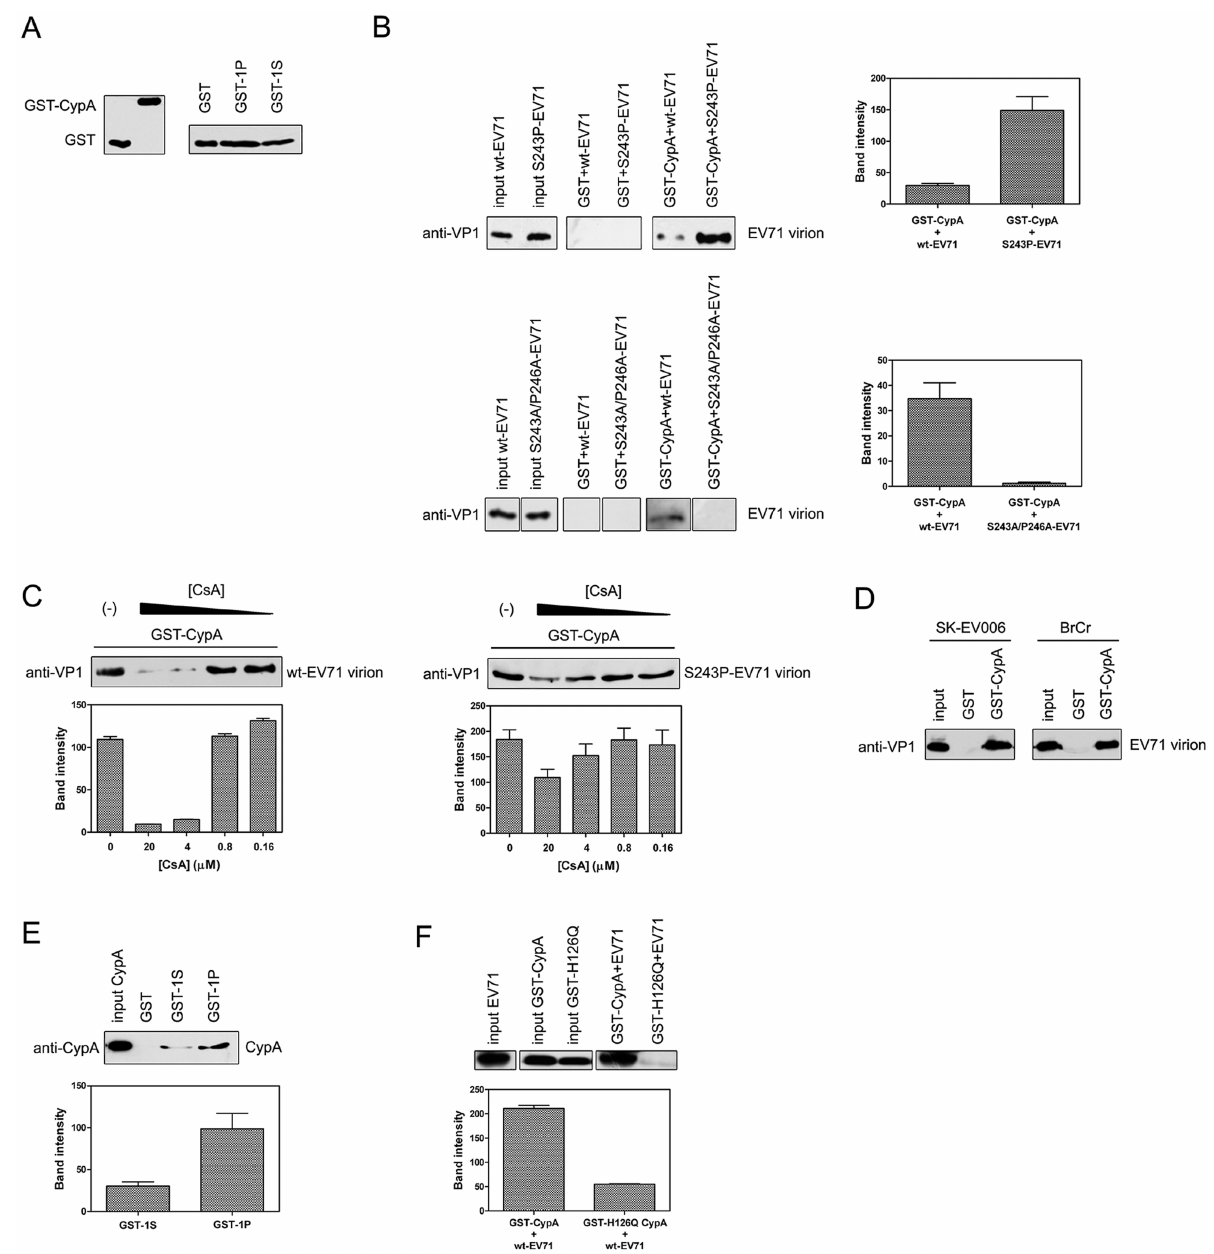
Figure 3. CypA interacted with the EV71 virion and the VP1 H-I loop. (A) Inputs that were used in the GST-pulldown assays. (B) The S243P- EV71 virion (upper panel) exhibited a higher, but S243A/P246A-EV71 (bottom panel) showed weakened binding affinity to CypA than the wt-EV71 virion (strain AnHui1). The bands indicating the interactions between GST-CypA with wt-, S243P-, or S243A/P246A-EV71 virions were quantified. Each column represents the average of three replicates. Error bars represent the SEM. (C) The CypA interaction with the EV71 virion (strain AnHui1) was disrupted by CsA in a dose-dependent manner, and the S-to-P substitution rescued this interaction. A GST pulldown assay between the GST-CypA and wt-EV71 or S243P-EV71 virions was performed in the absence (lane 1) or presence (lanes 2–5) of CsA. The CsA concentrations in lanes 2–5 are 20, 4, 0.8, and 0.16 m M, respectively. Similar amounts of wt- and S243P-EV71 viruses and GST-tagged CypA were loaded into the GST-pulldown assay. The bands were quantified and each column represents the average of three replicates. Error bars represent the SEM. (D) CypA was bound to different EV71 virions. SK-EV006 refers to the SK-EV006-LPS1 strain, and BrCr refers to the BrCr strain. (E) The mutation at position 243 increases the interaction of CypA with the H-I loop of EV71 VP1. All experiments were performed at least three times. The sequence of the 1S peptide is GSSKSKYPL, and the sequence of the 1P peptide is GSSKPKYPL. The bands for the wt-EV71 interactions with GST-1S or GST-1P were quantified. Each column represents the average of three replicates. Error bars represent the SEM. (F) A catalytic-defective mutant of CypA called H126Q significantly attenuated the binding of wt-EV71 virions to CypA. The bands for the interactions between wt-EV71 and CypA or the CypA mutant were quantified. Each column represents the average of three replicates. Error bars represent the SEM. The bands were quantified with ImageJ software.